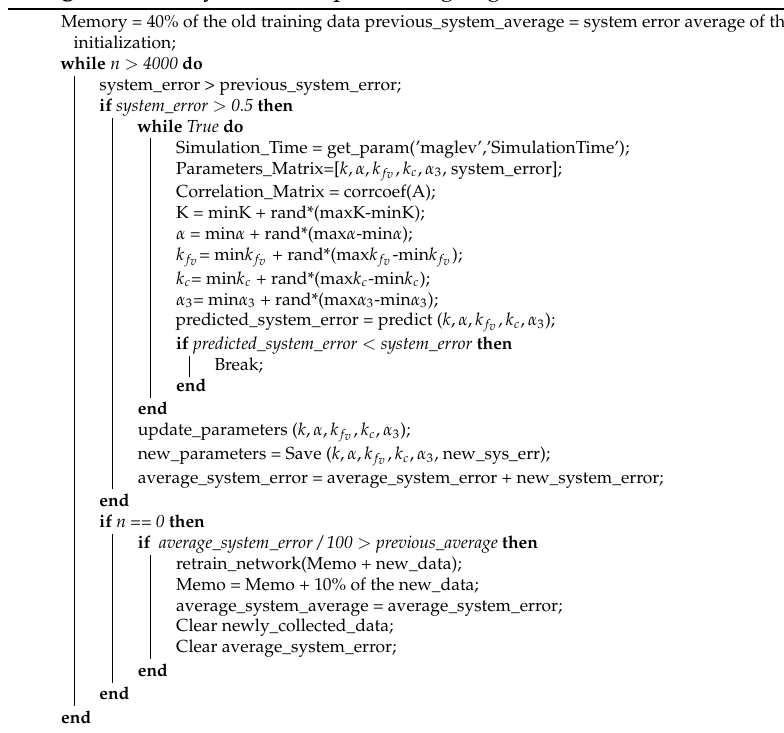
Algorithm 1: Dynamic Deep Learning